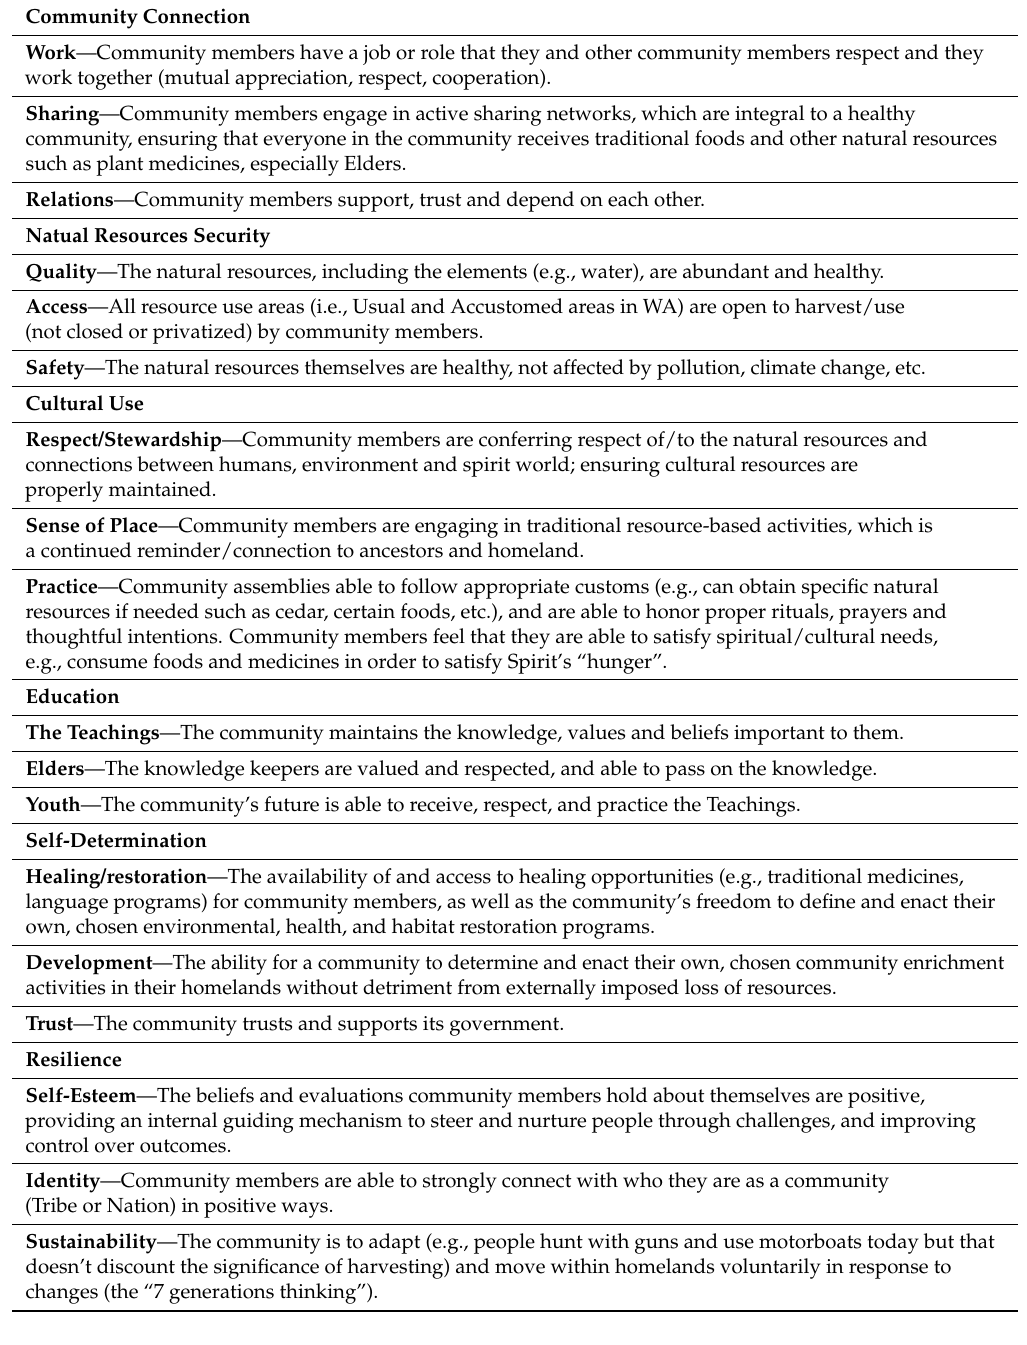
Table 1. Indigenous Health Indicators and respective